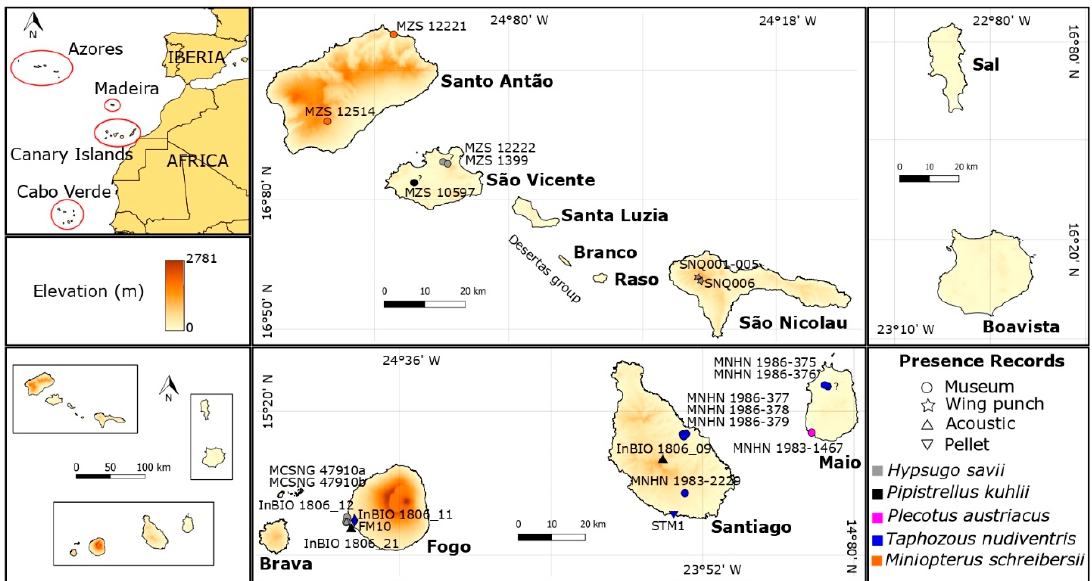
Figure 1. Study area and collected bat presence records. Map of the Cabo Verde Islands, showing the geographic location and elevation of the archipelago and its islands, and bat presence records. Each bats species is depicted with a different color and each sample type with a different shape. Question markers represent unknown locations. See Table S1 for more details.